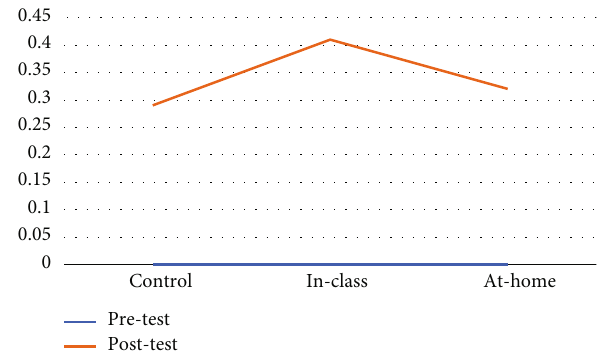
Figure 6: Comparisons of pretest and posttest scores in three